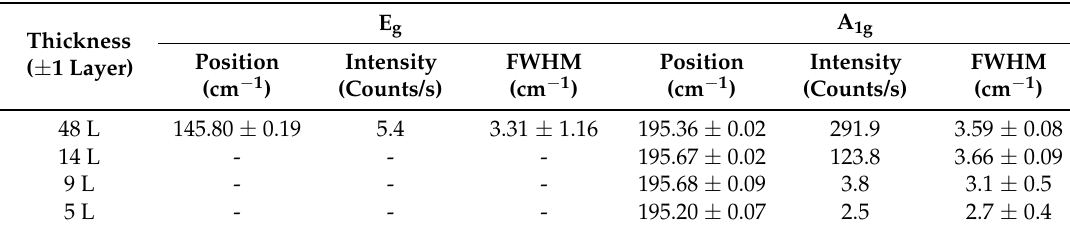
Table C3. Thickness dependence of the fitted parameters (position, intensity, and FWHM) of the E g and A 1g modes obtained from the Raman spectra for ZrSe 2 on a Si/SiO 2 substrate ( λ = 638 nm) presented in Figure C5.